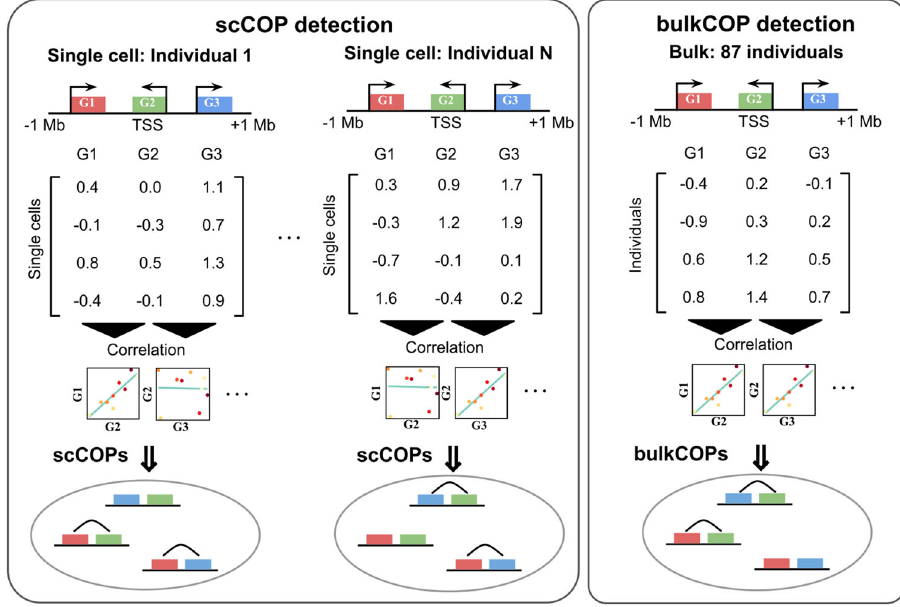
Fig. 1 Scheme of the single cell and bulk local gene co-expression detection approach across 87 individuals. Using normalised single-cell data, we identify scCOPs per individual based on measuring the gene expression correlation across all cells of the same individual. Using bulk data (right part of the plot) we identify bulkCOPs by correlating the expression levels of nearby genes across